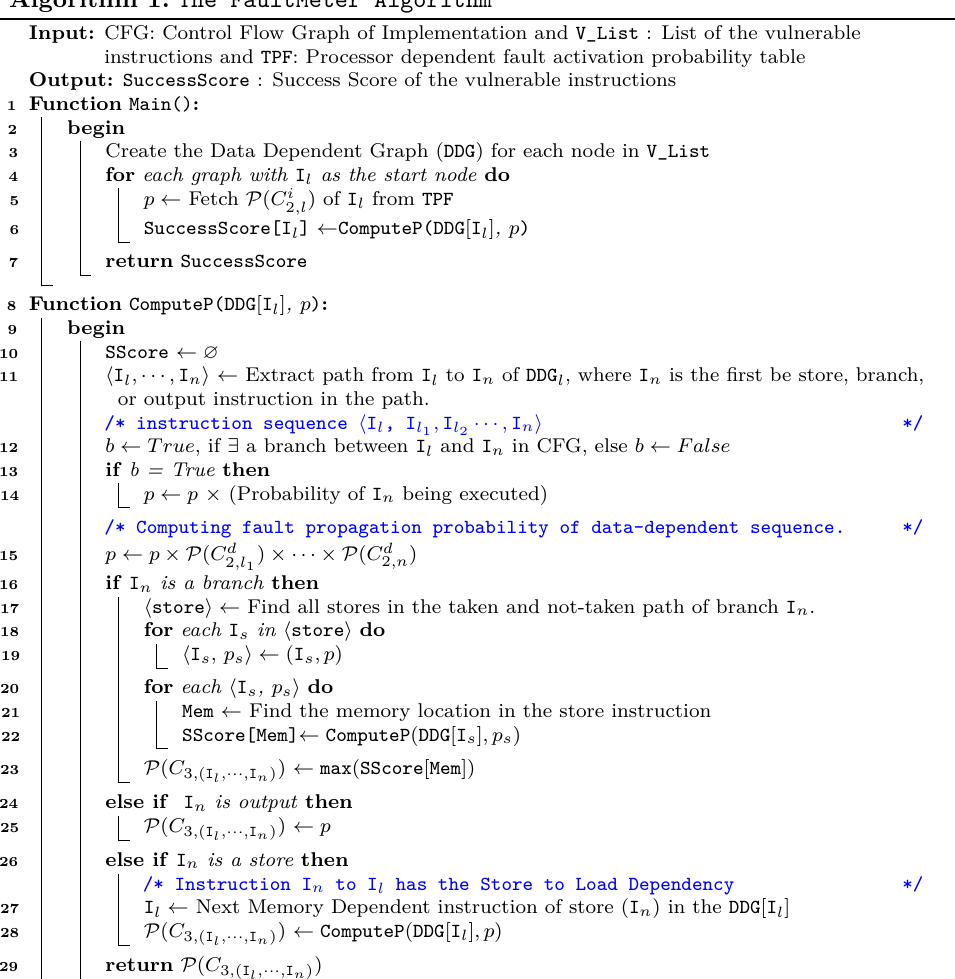
Algorithm 1: The FaultMeter